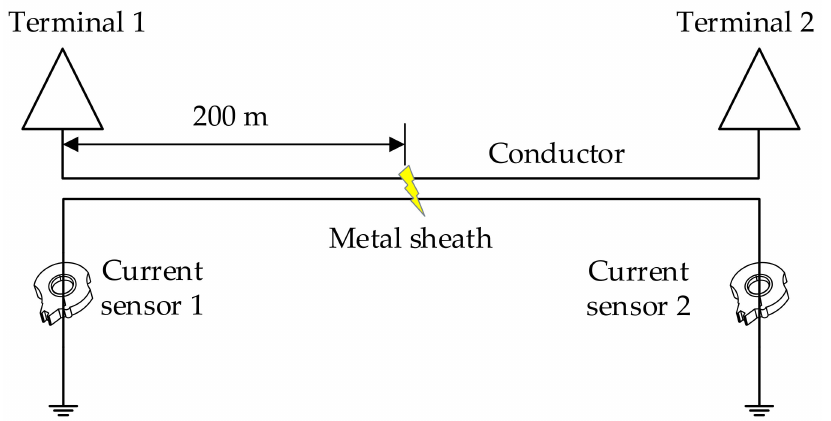
Figure 9. The schematic diagram of a double-end bonded medium voltage (MV) cable system. Note: ‘conductor’ has three cores, one for each phase. Table 5. The parameters of cross-sectional structure of the MV cable.